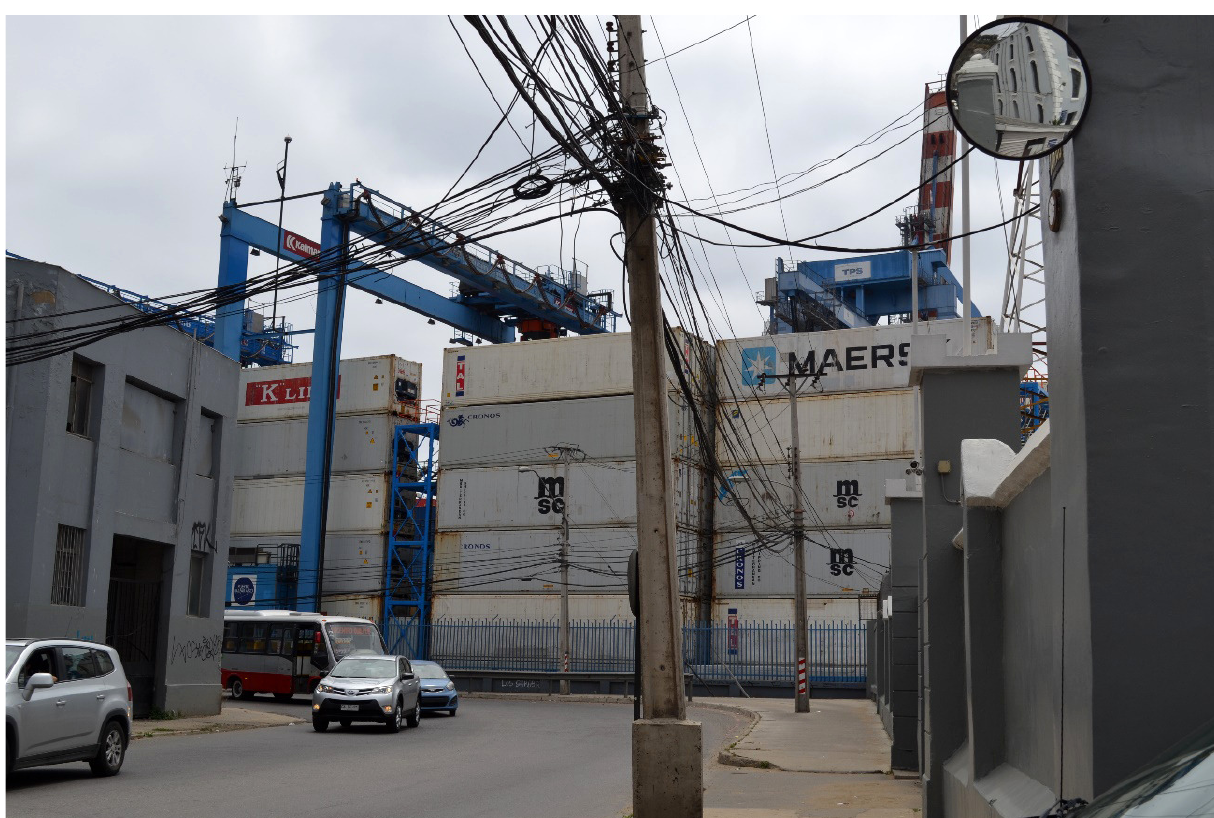
Figure 8. Walled port of Valparaíso. Source: Hernán Cuevas (photograph taken circa